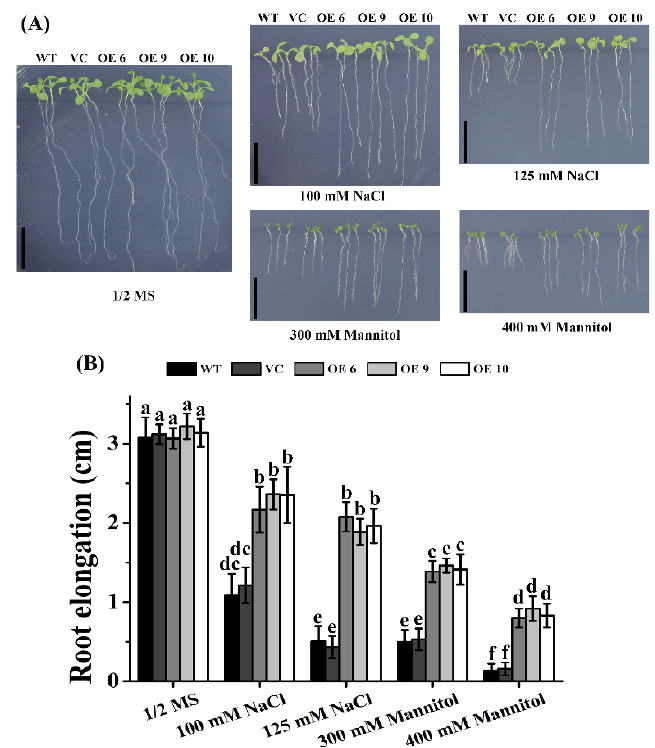
Figure 4. Effects of NaCl and mannitol on primary root growth of Arabidopsis transgenic plants overexpressing TaTIP4;1 . ( A ) Seedling growth performances. Five-day old seedlings of OE6, OE9, OE10, WT and VC were transferred to 1/2 MS medium supplemented without or with 100 mM NaCl, 125 mM NaCl, 300 mM mannitol or 400 mM mannitol, and grown for another 10 days. Scale bars are 1 cm. ( B ) Increments in the length of primary roots of various lines in ( A ). Values are mean ± SD (n ≥ 3). Different lowercase letters above the error bars indicate that the values of the lines significantly differed from each other by one way ANOVA and Tukey’s HSD test ( p < 0.05).